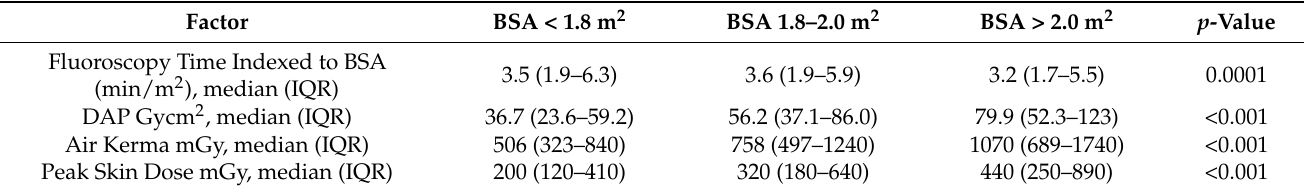
Figure 1. Correlation of different anthropometric indices with dose area product (DAP). R 2 = correlation coefficient, and represents proportion of variance in DAP explained by each variable in linear regression model. BMI, body mass index; DAP, dose area product. Table 3. Radiation measures for whole cohort, including indexed fluoroscopy time, dose–area product, air kerma and peak skin dose.